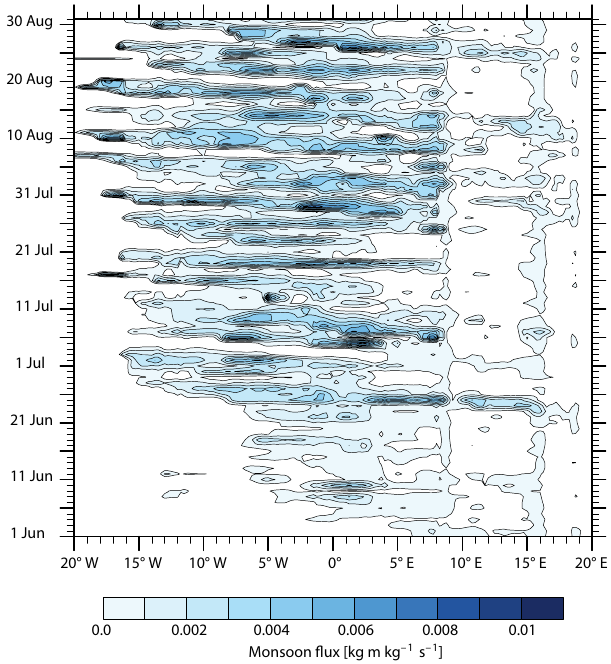
Figure 11. Meridional monsoon flux (kgmkg − 1 s − 1 ) at 20 ◦ N at surface level calculated as the product of the northward component of the meridional wind and the specific humidity, both at 10m above ground